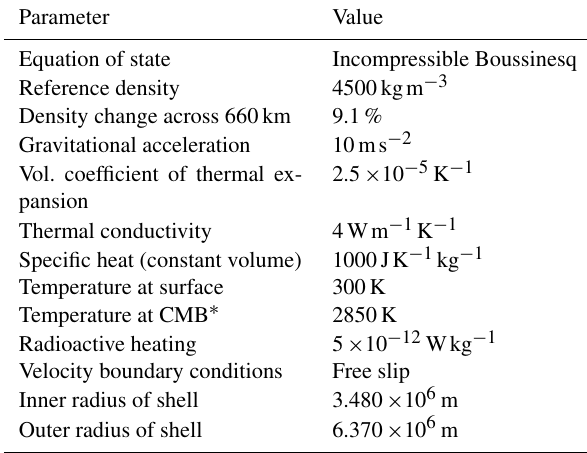
Table 1. Common input